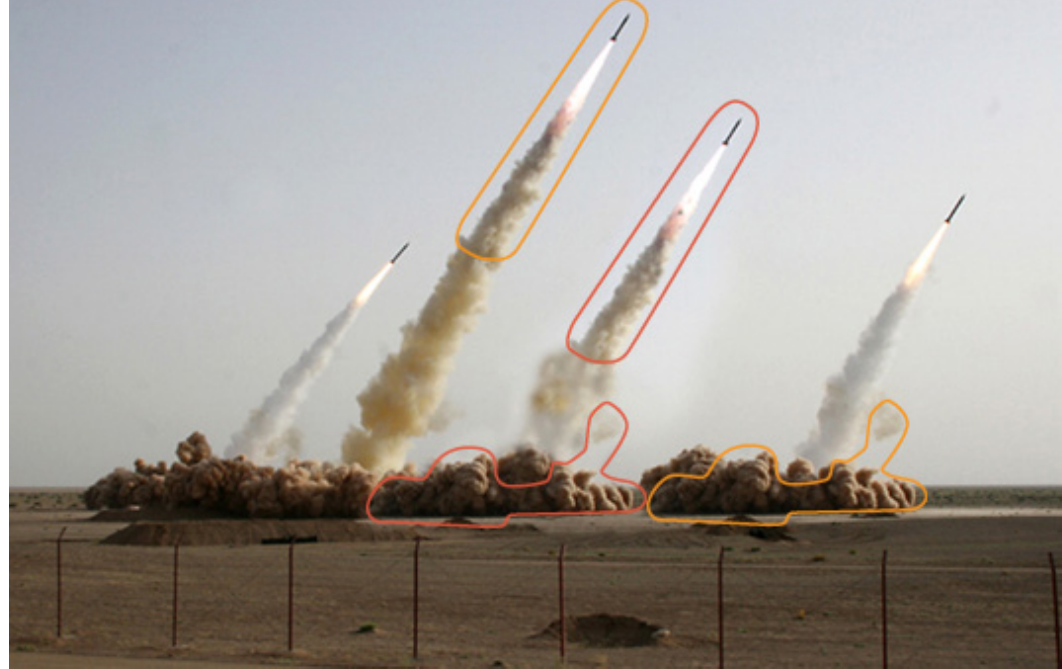
Figure 5 - The Iranian Missile Case (Shachtman 2008, Nizza and Lyons 2008). Patterns of a successful missile launch were replicated to the failing one, a clear case of copy-pasting portions of an image so as to change its meaning. Illustration by The New York Times; photo via Agence